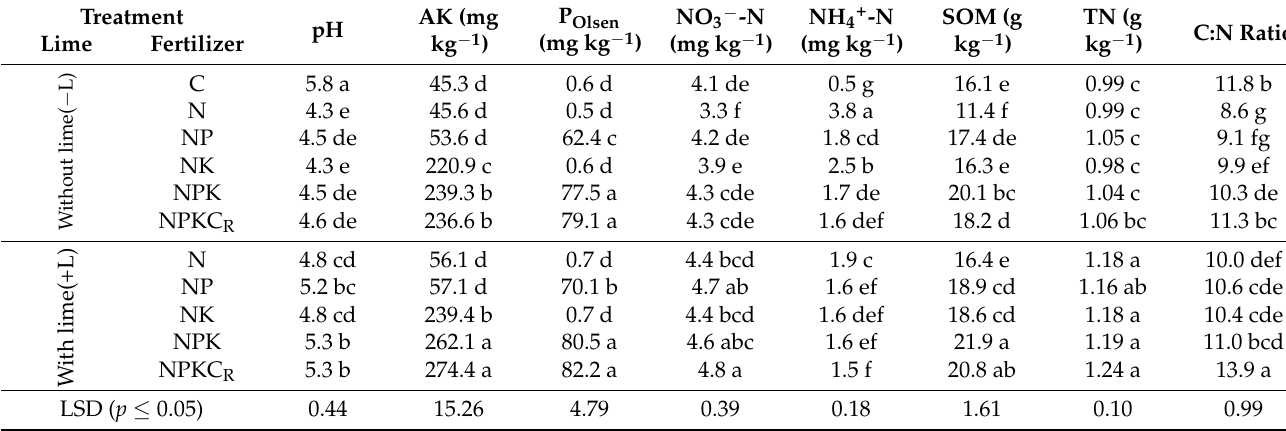
Table 2. Soil chemical properties of the 0–20 cm soil layer as a function of the applied fertilization. Average values of 2011–2018 (after